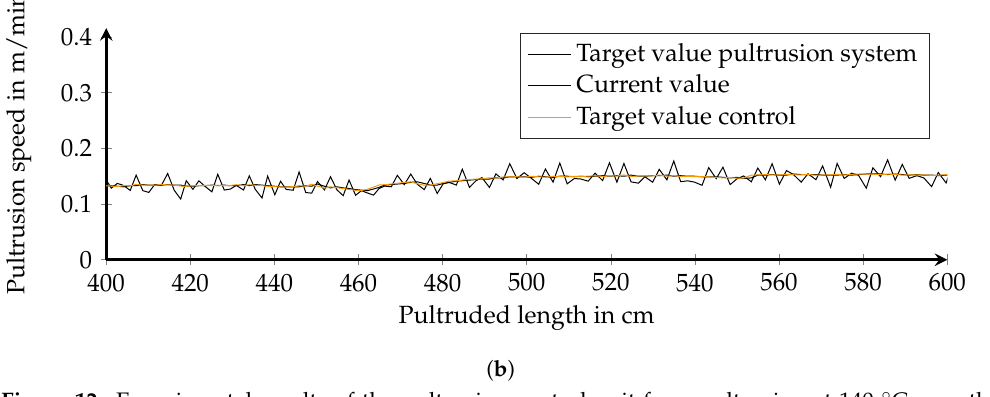
Figure 12. Experimental results of the pultrusion control unit for a pultrusion at 140 ◦ C over the length of the pultruded material between 400 and 600cm. ( a ) Sensor signal between 400 and 600 cm; ( b ) pultrusion speed between 400and 600cm.